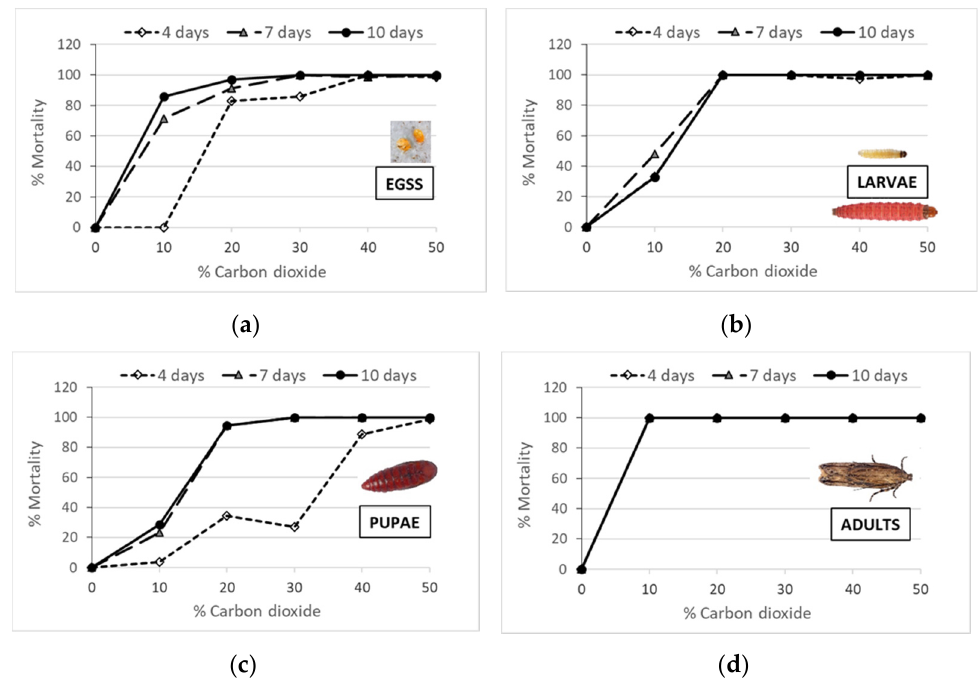
Figure 3. Insect mortality curves when exposed ( a ) eggs, ( b ) larvae, ( c ) pupae, or ( d ) adults were exposed to an enriched atmosphere in 0, 10, 20, 30, 40, and 50% carbon dioxide; 20% oxygen; and the rest nitrogen for 4, 7, or 10 days. Photos: F. Correa.